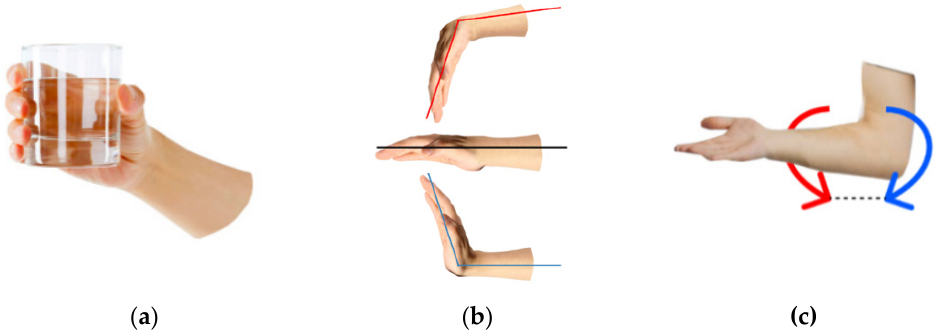
Figure 6. Basic wrist movements: ( a ) grasping, ( b ) flexion/extension, and ( c ) rotation.